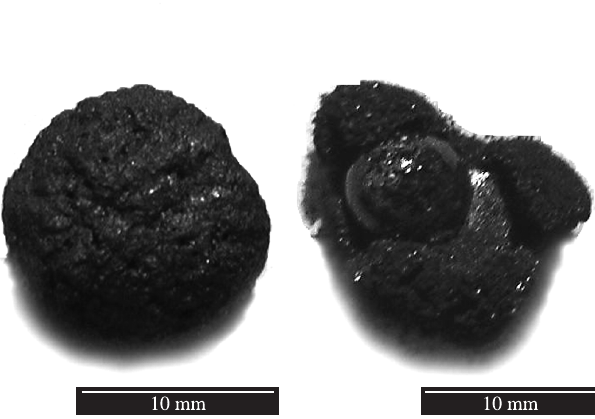
Figure 6. Iron ore-graphite pellets after the experiment; left, pellet with 7% of Portland ® cement (high liquidus temperature slag); right, pellet with 7% of a mixture of Portland ® cement, silica and alumina (low liquidus temperature slag).